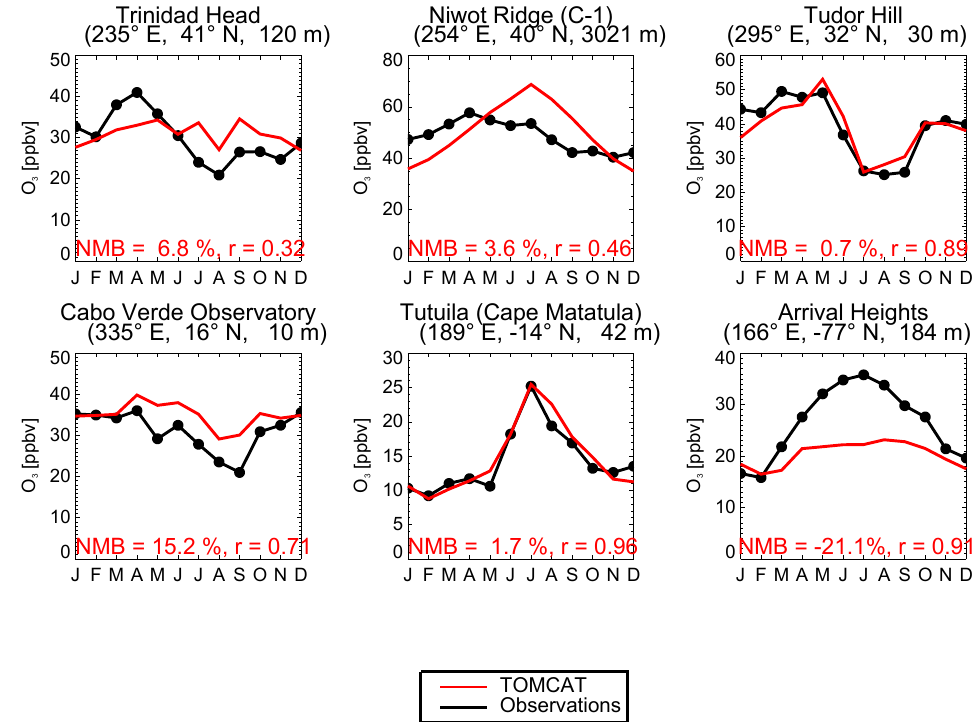
Figure 8. Monthly mean 2008 observed and simulated O 3 (ppbv) at several surface sites located throughout the globe. The panels are arranged by latitude from north to south, with Pearson correlation ( r ) and normalised mean bias (NMB) between the observed and simulated monthly mean data printed on each panel.